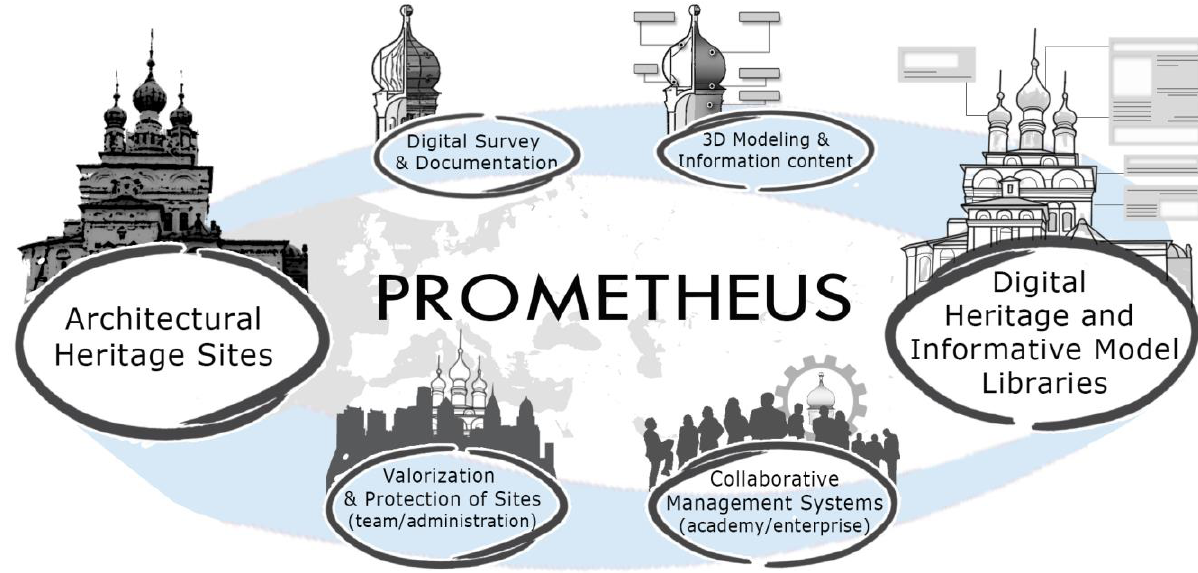
Figure 4. Methodological and action framework of H2020 RISE project